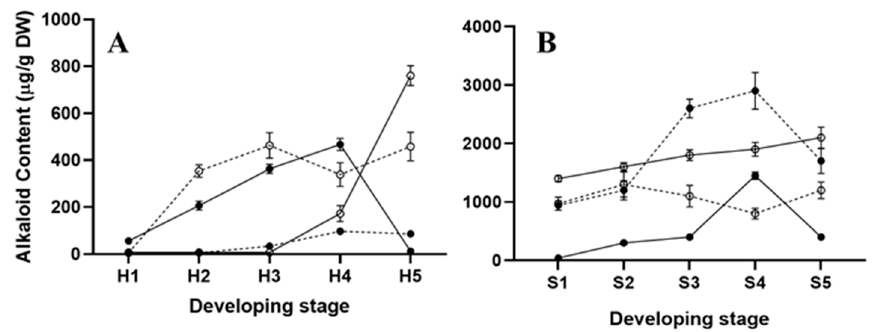
Figure 3. Alkaloid contents in different tissues in the hypocotyl ( A ) and seedling ( B ) throughout different developmental stages in A. mexicana . The developmental stages labeled 1 to 5 correspond to H1 to H5 ( A ) or S1 to S5 ( B ), as described in the text. The closed and open circles represent the alkaloid contents in cotyledons and radicles, respectively, whereas the continuous and dashed lines stand for sanguinarine and berberine, respectively. The average of triplicates with the standard deviation is given.